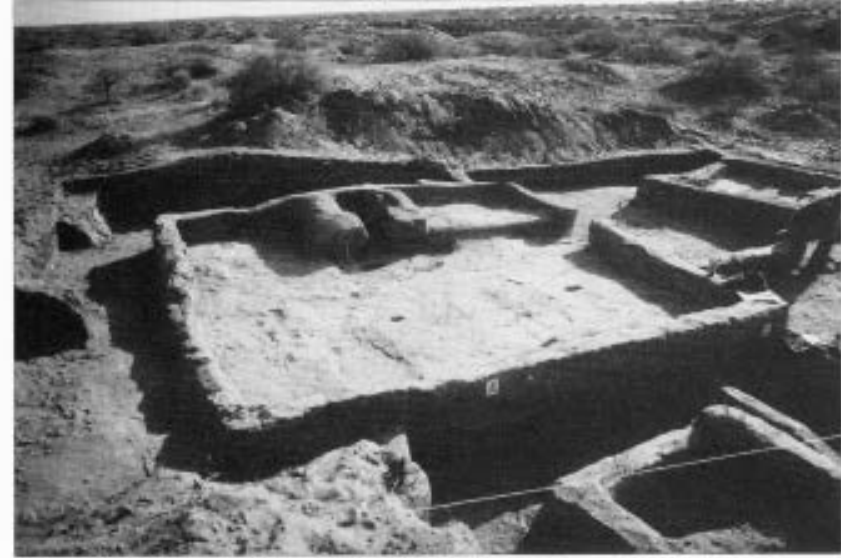
Figure 5 Rectangular mud brick house at feitun excavated in 1989, showing interior oven, adjacent platform and doorway, and "yard" areas outside the